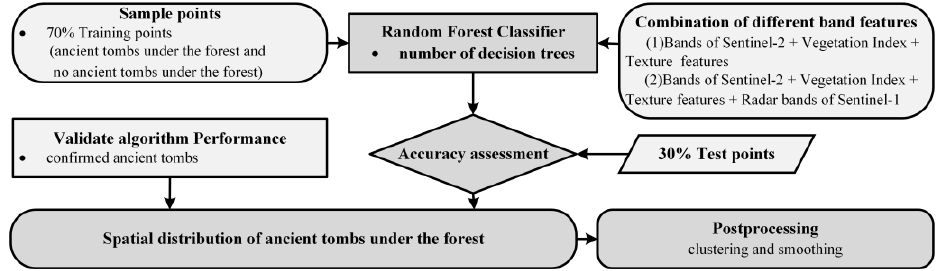
Figure 13. Flow chart of automatic identification algorithm of ancient tombs under the forest.